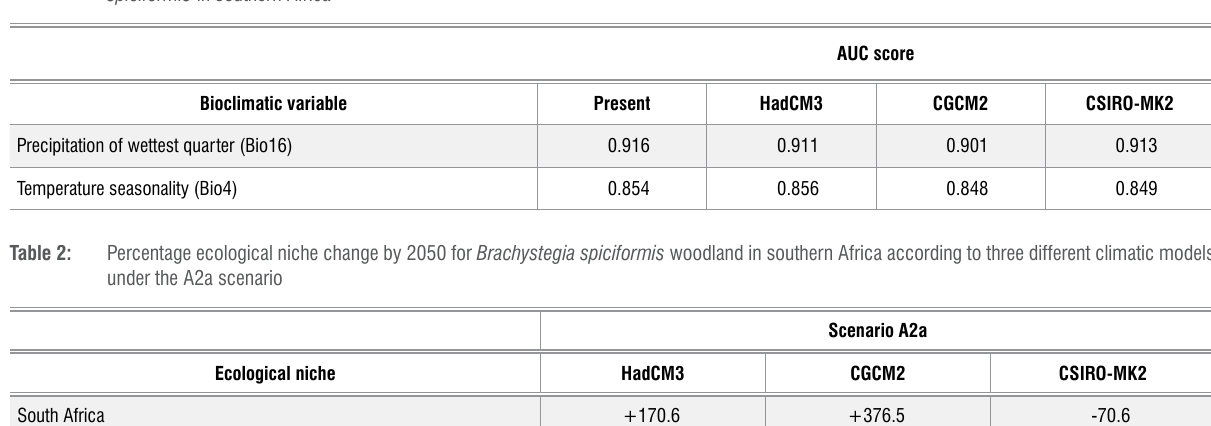
Area under the curve (AUC) scores for top-performing bioclimatic variables explaining current and three future distributions for Brachystegia spiciformis in southern Africa